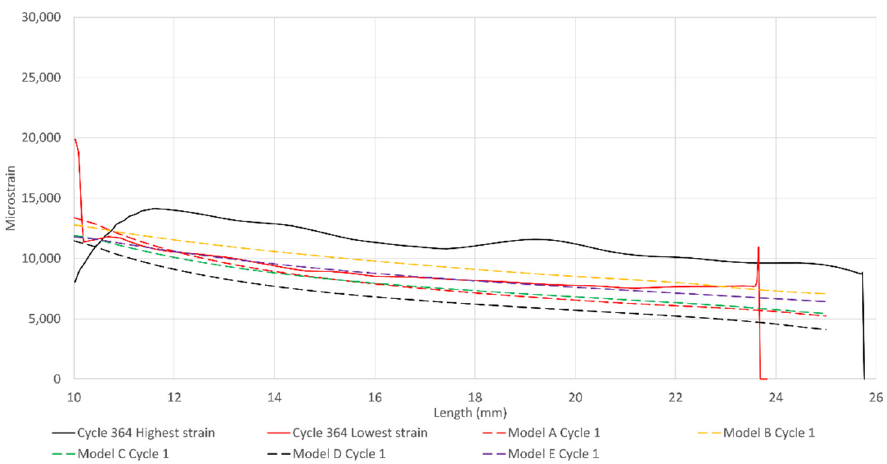
Running the FE analysis for each matrix cracking material model described in Tables